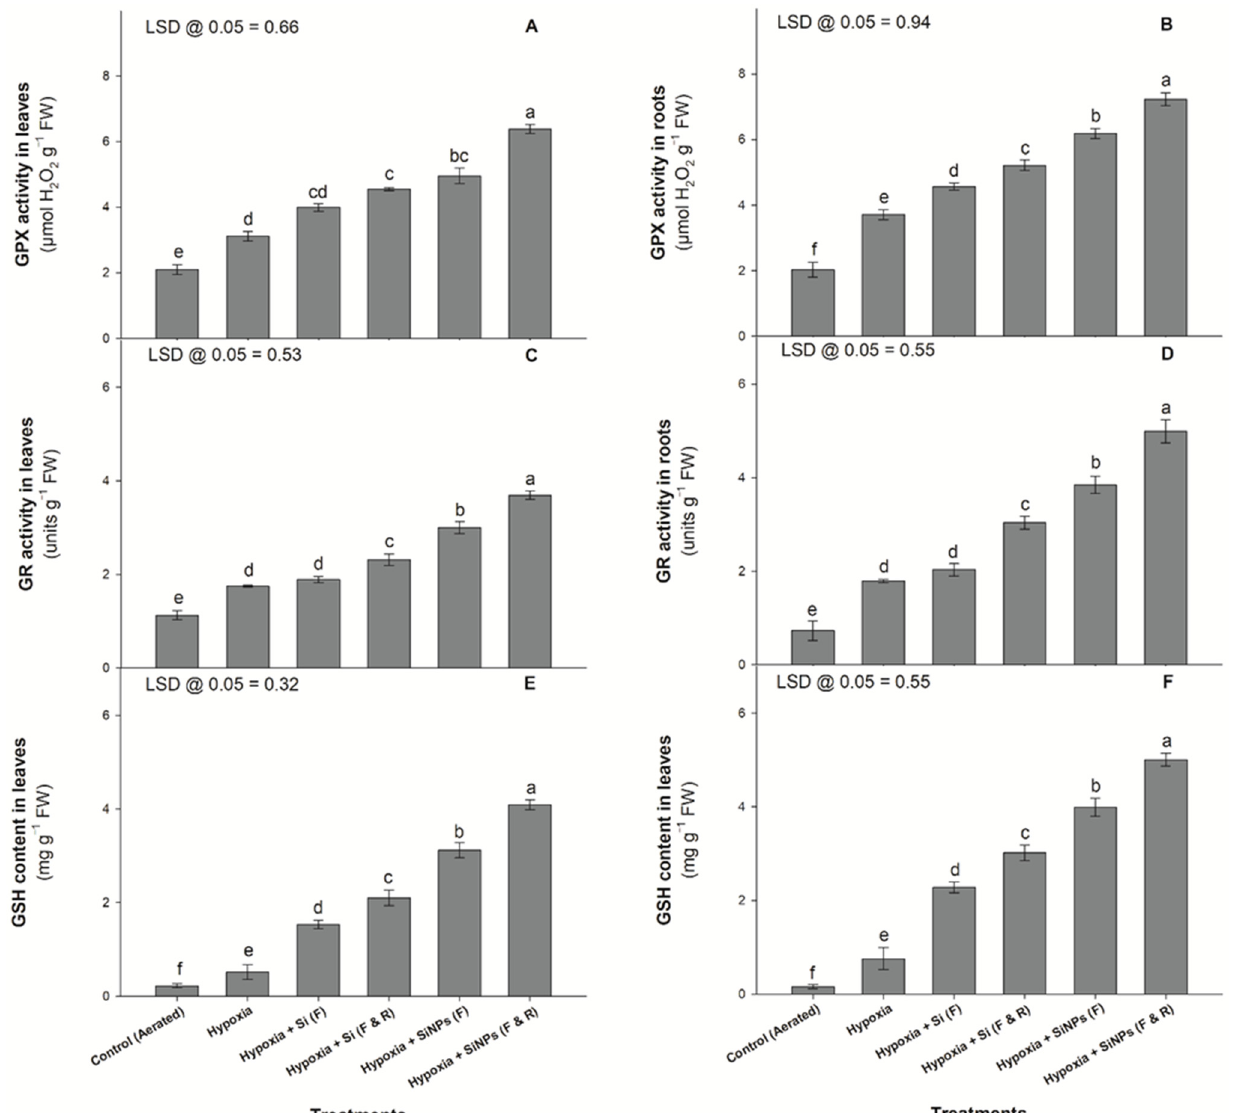
Figure 5. GPX activity ( A , B ), GR activity ( C , D ), and GSH content ( E , F ) in leaves and roots of blueberry plants in response to six treatments i.e., (i) control (aerated), (ii) hypoxia, (iii) hypoxia + Si (F), (iv) hypoxia + Si (F & R), (v) hypoxia + SiNP (F), (vi) hypoxia + SiNPs (F & R). Values are mean of four independent replicates ( n = 4) ± SE (shown in vertical bars), and values denoted by different letters (in small alphabets) differ significantly at p < 0.05, using the LSD test. The abbreviations used are F: foliar application of Si or SiNP; F & R: combined foliar and root zone application of Si; GPX: guaiacol peroxidase; GR: glutathione reductase; GSH: glutathione; R: root zone application of Si or SiNP; Si: conventional silicon; SiNPs: silicon nanoparticles.